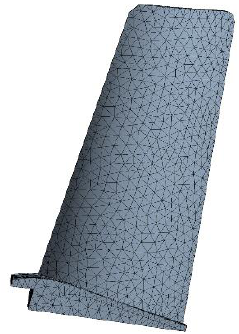
Figure 3. Finite element model of the blade.